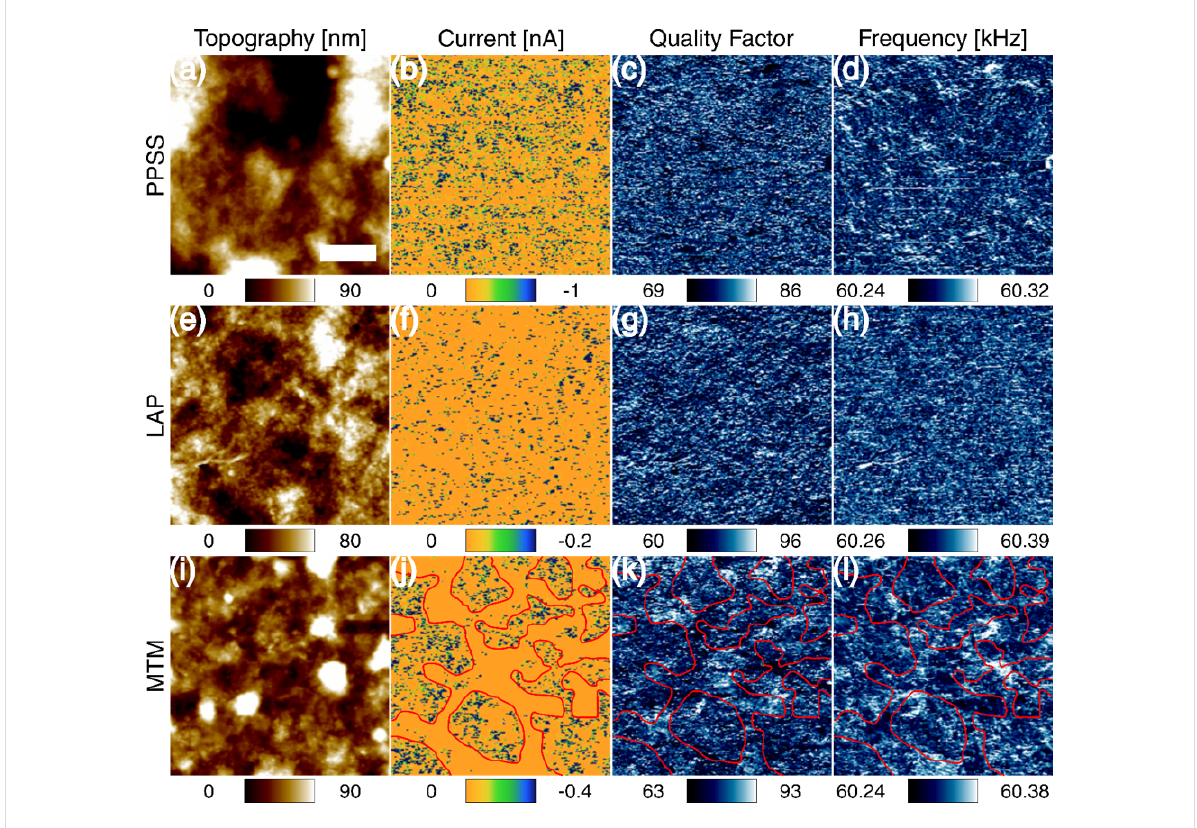
Figure 3: Typical correlated electro-mechanical properties of the thin samples: PEDOT:PSS (a–d), Laponite RD nanocomposite (e–h) and Cloisite Na + nanocomposite (i–l). The columns represent topography, current, quality factor and contact-resonance frequency, respectively. The red outlines relate the electrical conductivity and mechanical parameter behavior for MTM. The scale bar is 1 μ